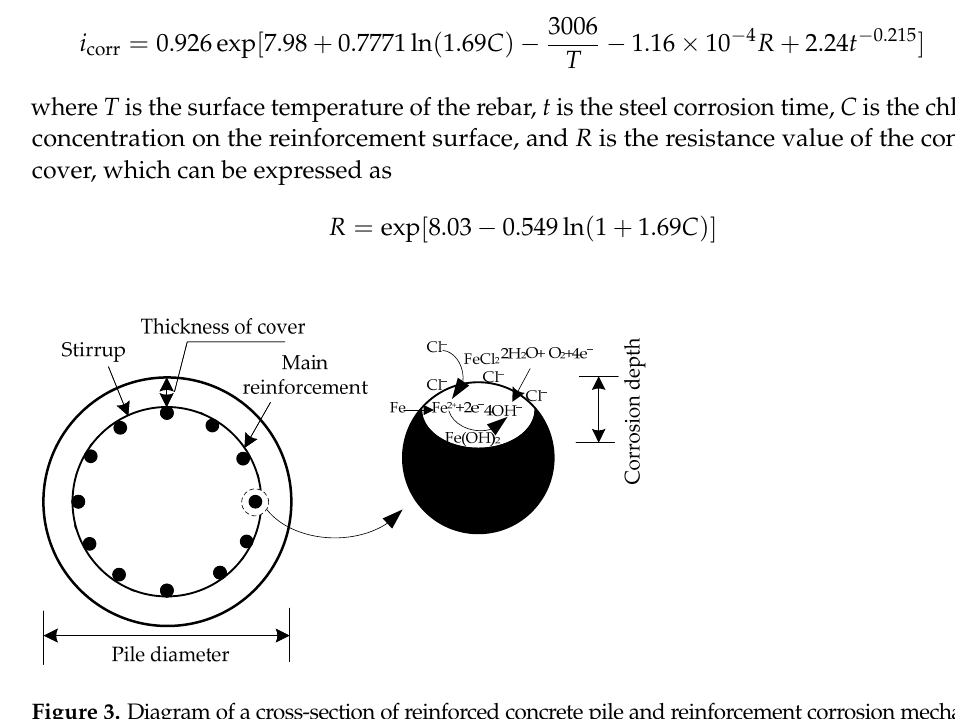
Figure 4. Deformation and difference diagram of the pile under horizontal load.